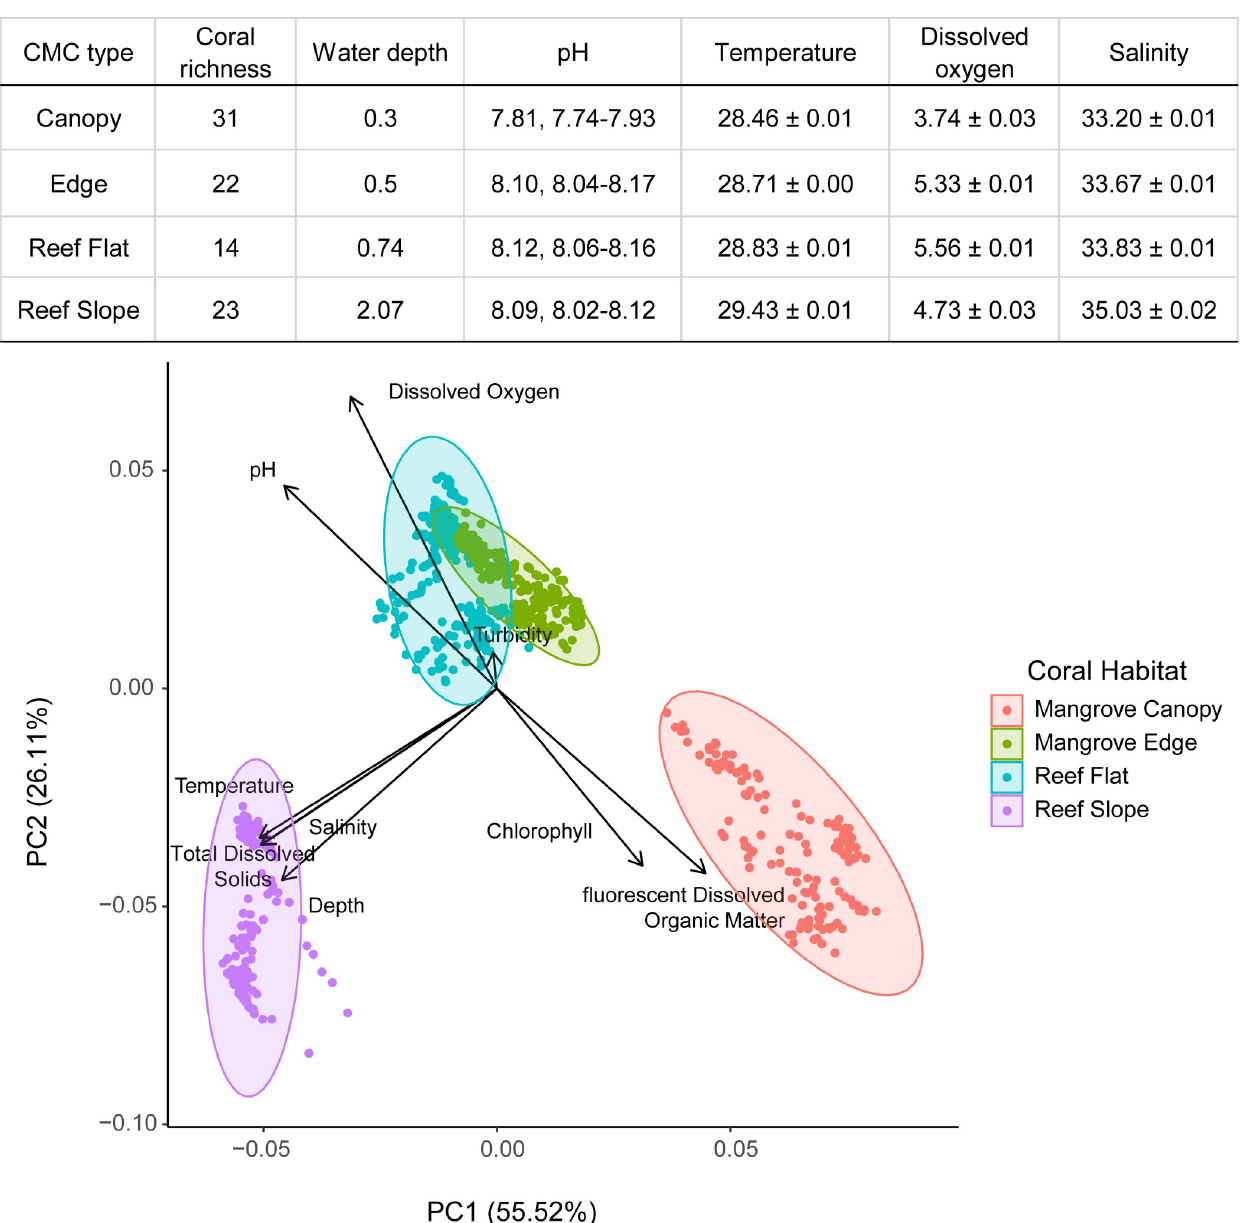
Fig 5. Abiotic distinction of coral habitats in Bocas del Toro, Panama. Principal Component Analysis of chlorophyll, fluorescent dissolved organic matter (fDOM), temperature, salinity, total dissolved solids (TDS), dissolved oxygen (ODO), and pH over four coral habitats in September 2019. Values given as mean ± SE except pH which is mean and range values. Units are meters for water depth, ˚C for temperature, mg/L for dissolved oxygen, and PSU for salinity.